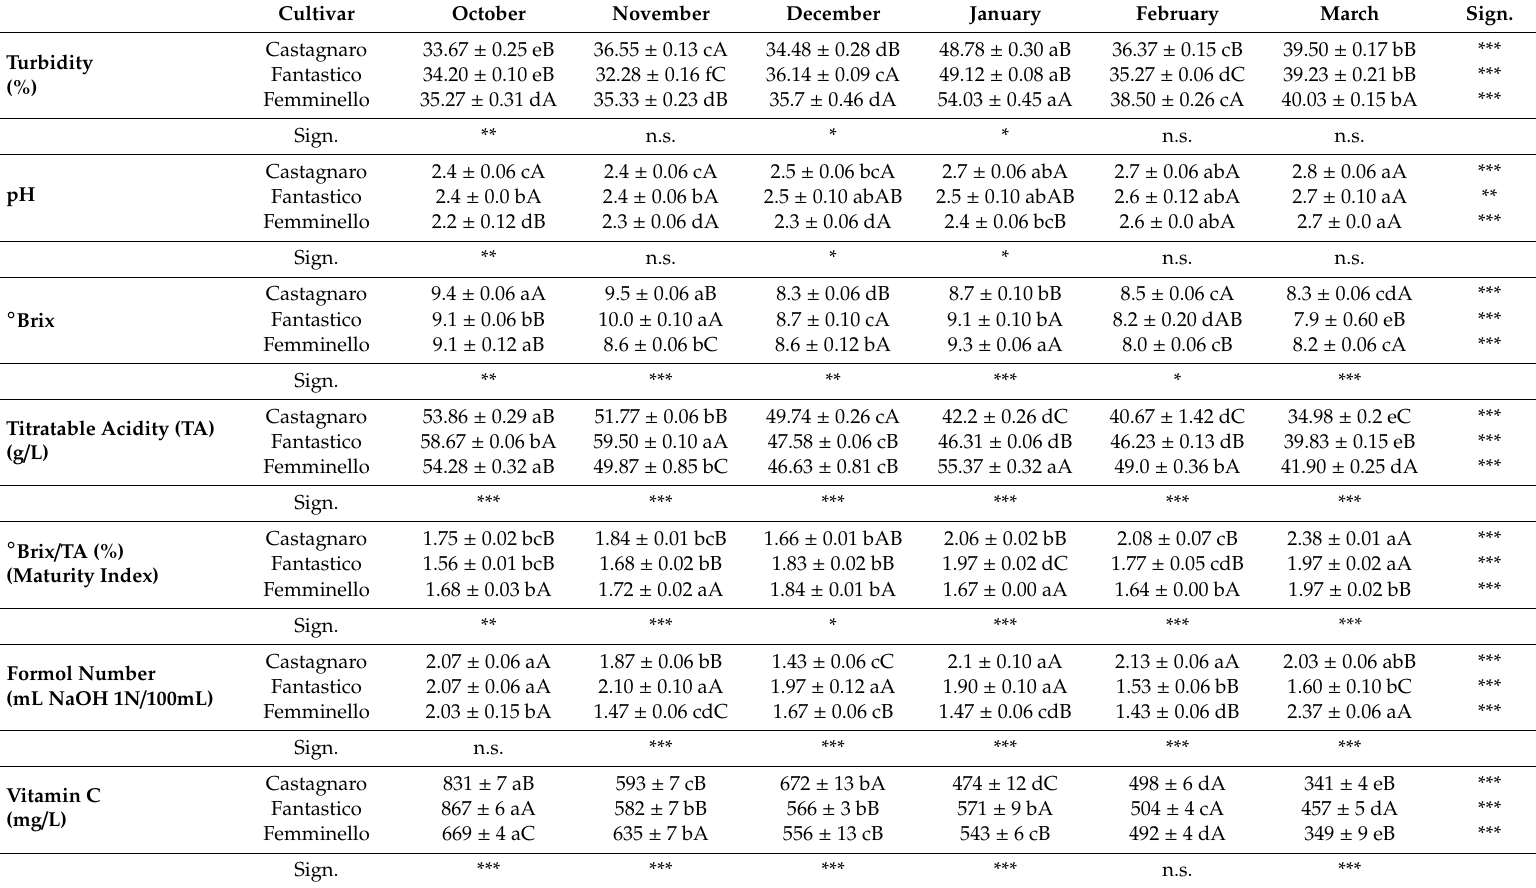
Table 4. Physico-chemical properties of bergamot juice. Results are presented as the mean value ± standard deviation, n = 8, (2016–2017 and 2017–2018 harvest years). *** significance at p < 0.001; ** significance at p < 0.01; * significance at p < 0.05; n.s., not significant. Means in the same line are distinguished by small letters. Means in the same column are distinguished by capital